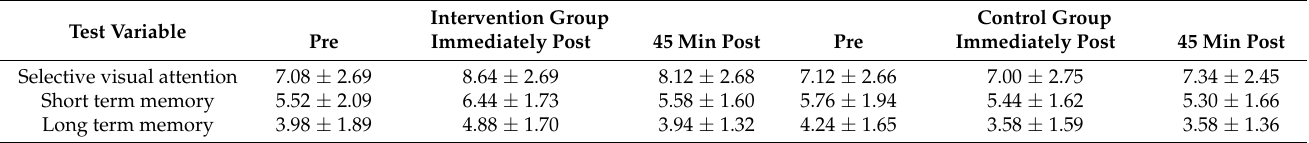
Table 1. Cognitive function across the morning in the intervention and control groups. Data are mean. Test Variable Selective visual